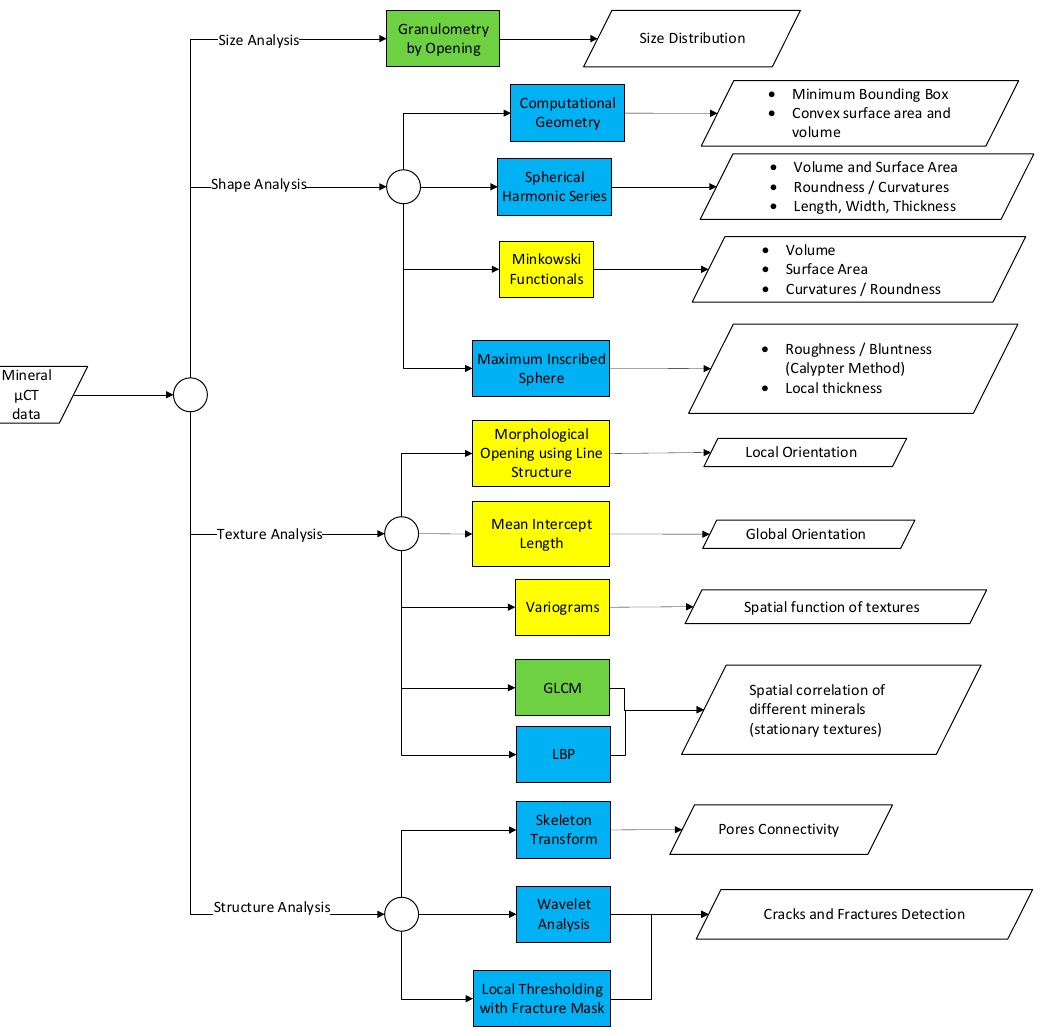
Figure 15. Workflow showing different alternatives in characterization of ore sample using a µCT system and the resulting information. The colors indicate the applicability of the methods. Green indicates that the methods have been implemented for µCT analysis of ore samples. Blue is for methods that have not been implemented specifically for µCT mineral characterization but have been implemented for similar materials such as dirt particles, aggregates, metal powders, and rocks. Yellow is for methods that have only been implemented for µCT analysis of materials that have little similarity to ore samples, such as soil and fibrous networks. Table 2. Summary of phase segmentation techniques applied in mineral characterization using µCT system.